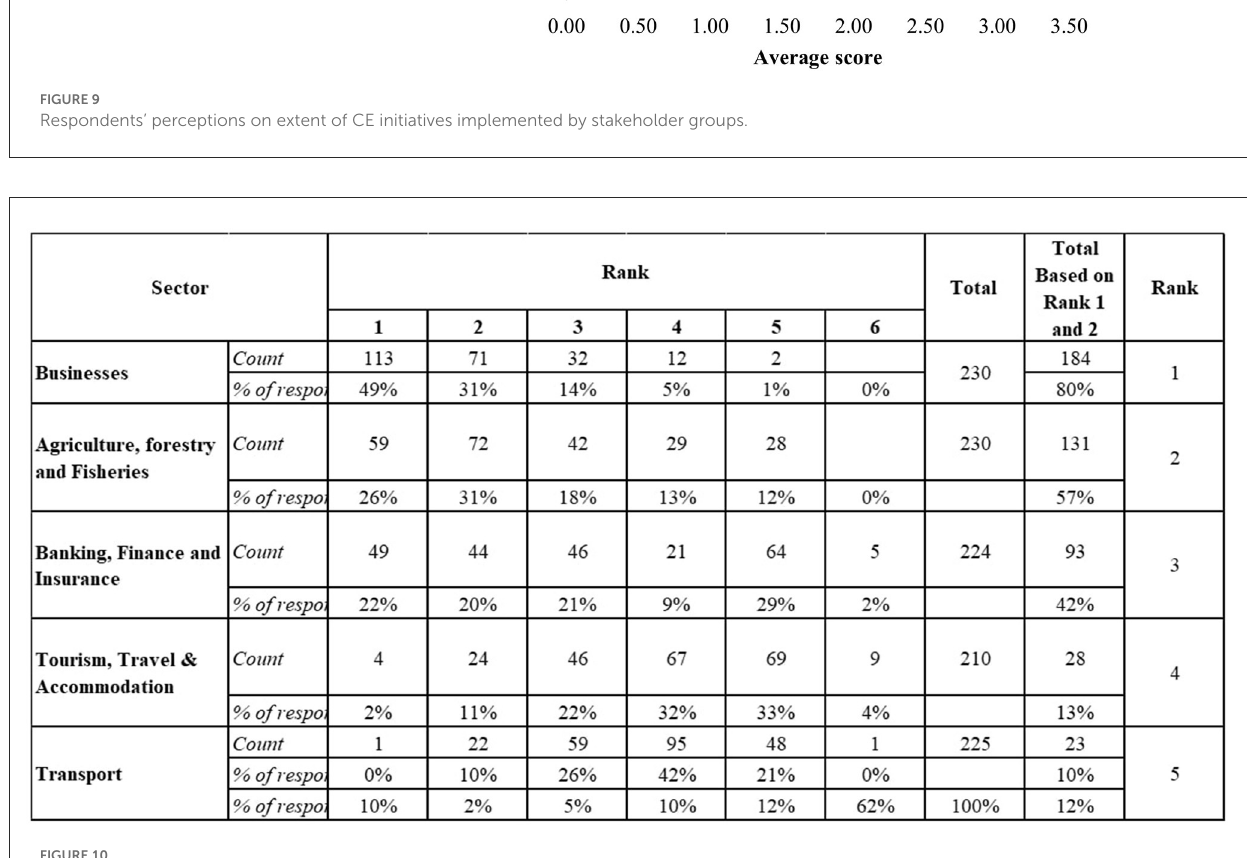
FIGURE10 Priority sectors in Uganda’s CE